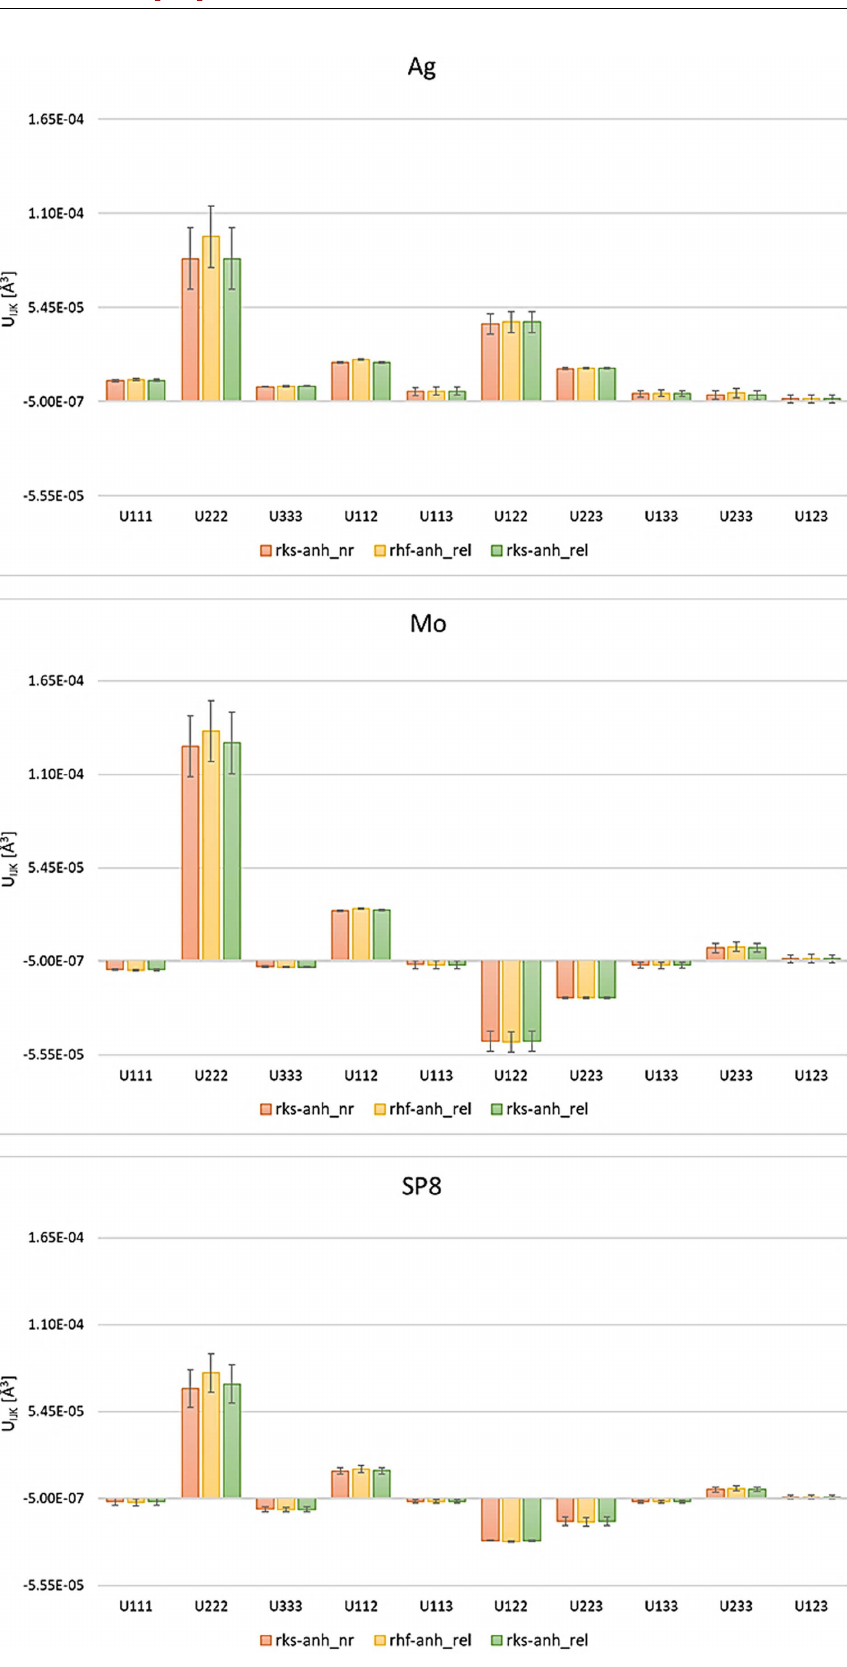
Figure 5 Plot of the numeric values of the significant third-order GC coefficients within three e.s.d.s for Ag, Mo and SP8 data for HARs at different levels of